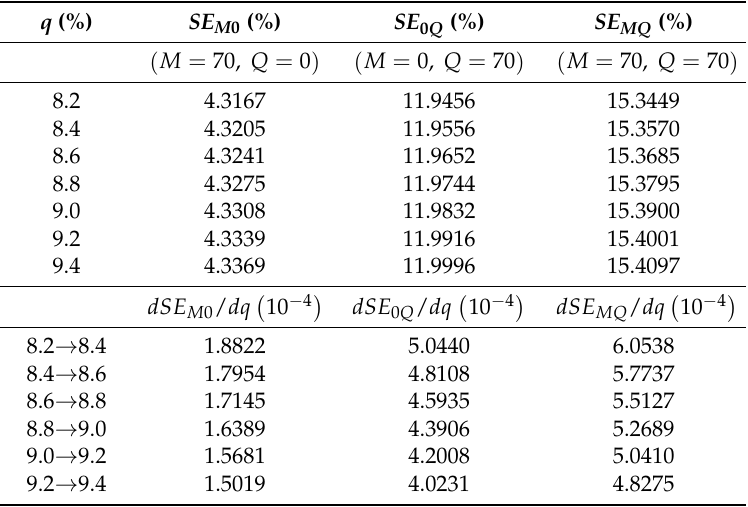
Table 10. Responsiveness of the bank’s scope equities to capital-to-deposits ratio at various levels of WMPs and ELs 1